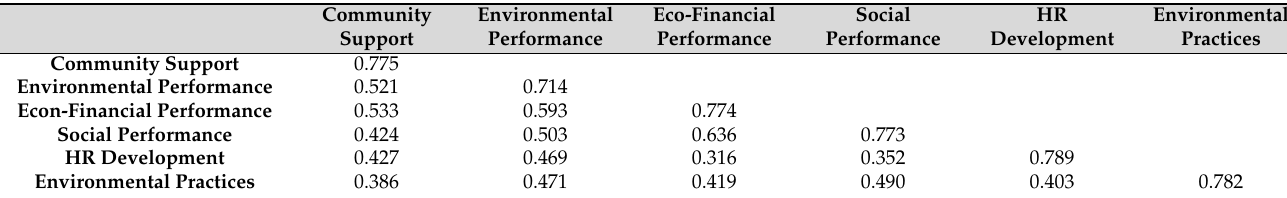
Table 9. Discriminant Validity (Fornell and Larcker Criterion).